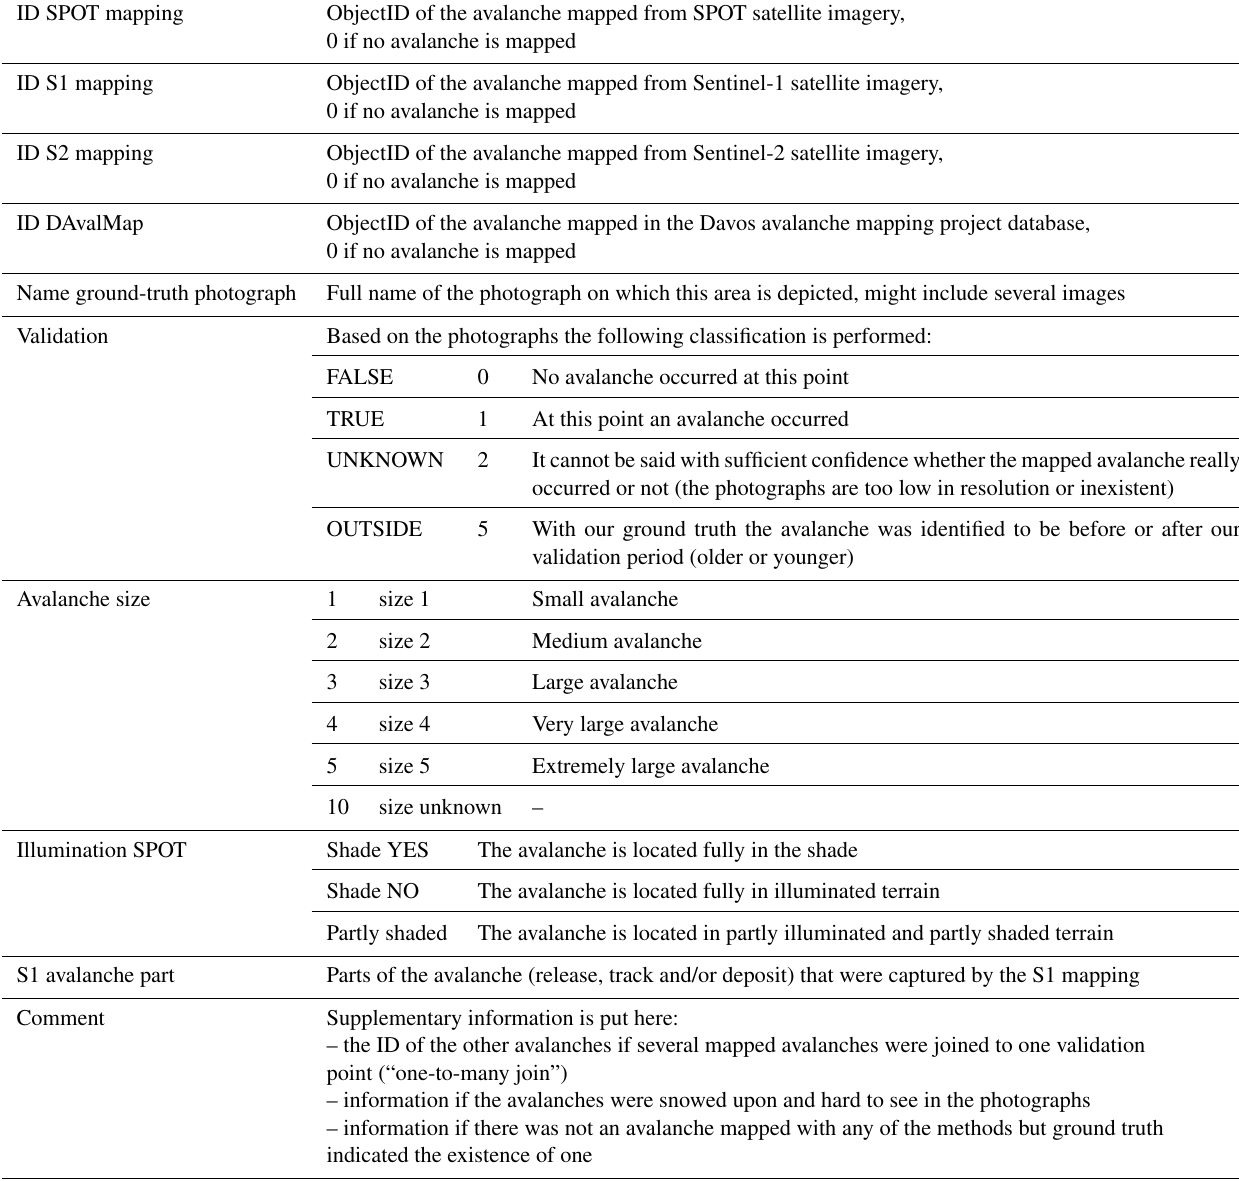
Table C1. Properties and required attributes for each validation point. ID SPOT